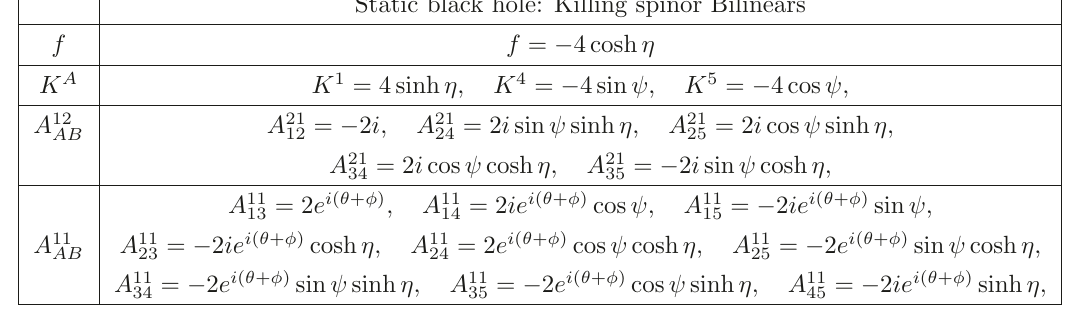
Table 2 . Independent non-zero spinor bilinears for the Killing spinor, ǫ 1